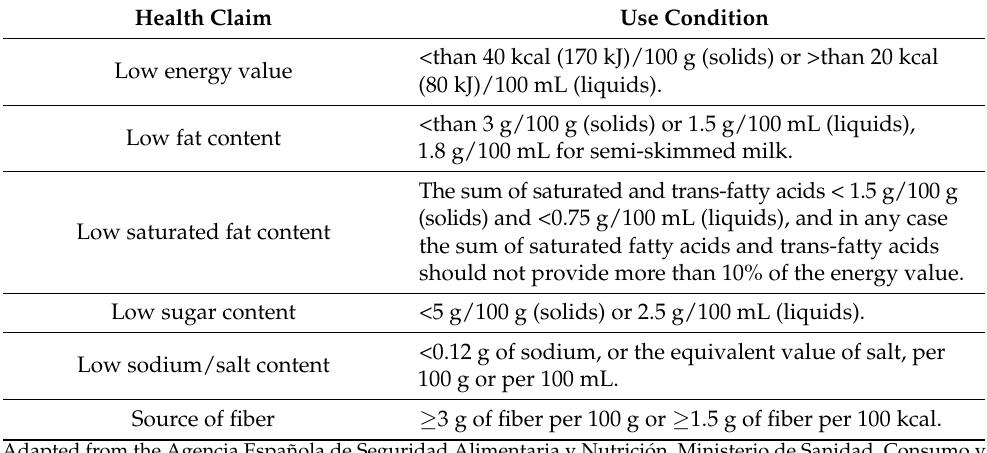
Table 2. Classification of critical nutrients. Levels Total Fat (g/100 g) Saturated Fat (g/100